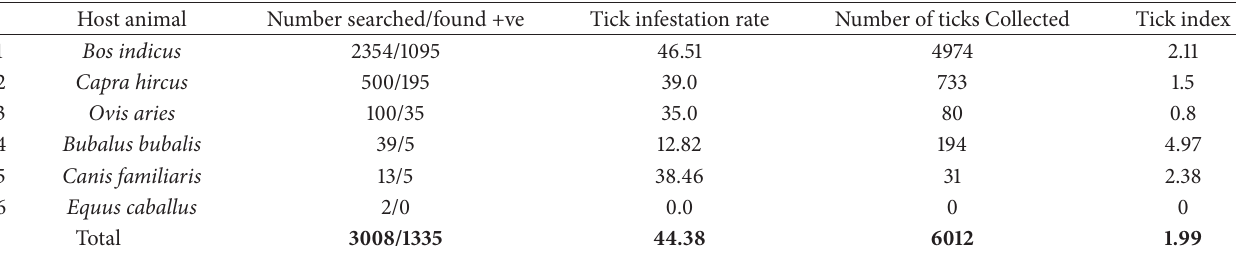
Table 2: Tick infestation rate and tick index in Nilgiri hills study